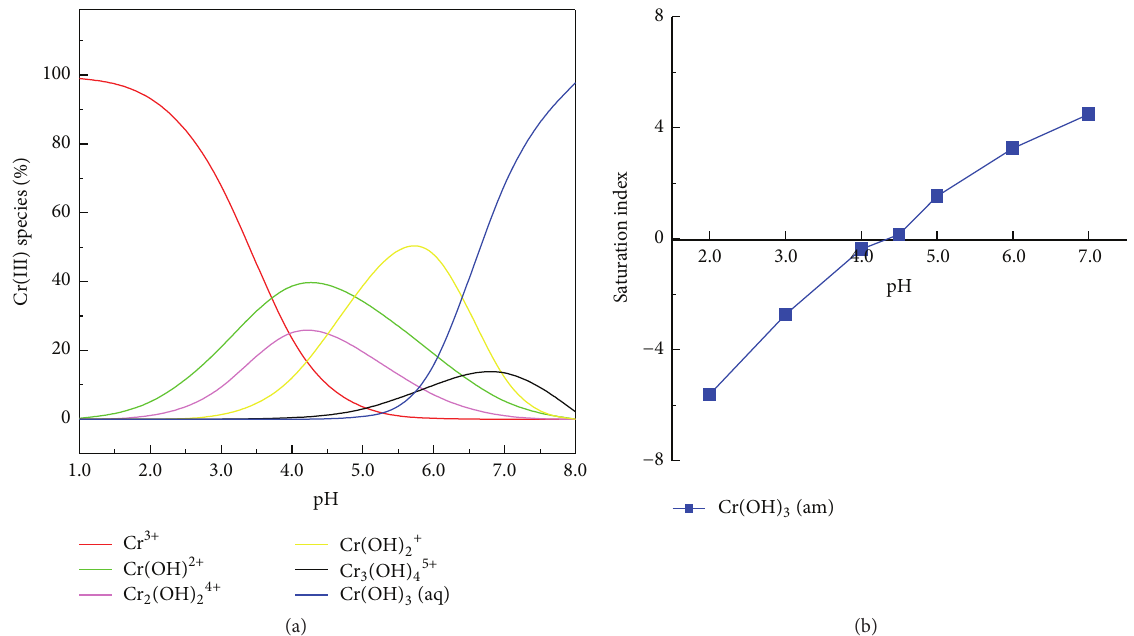
Figure 5: The speciation pH plot of Cr(III) (a) in absence of Cu(II) and the saturation index with respect to Cr(OH) 3 in solution with 300 mg ⋅ L −1 Cr(III) at 25 ∘